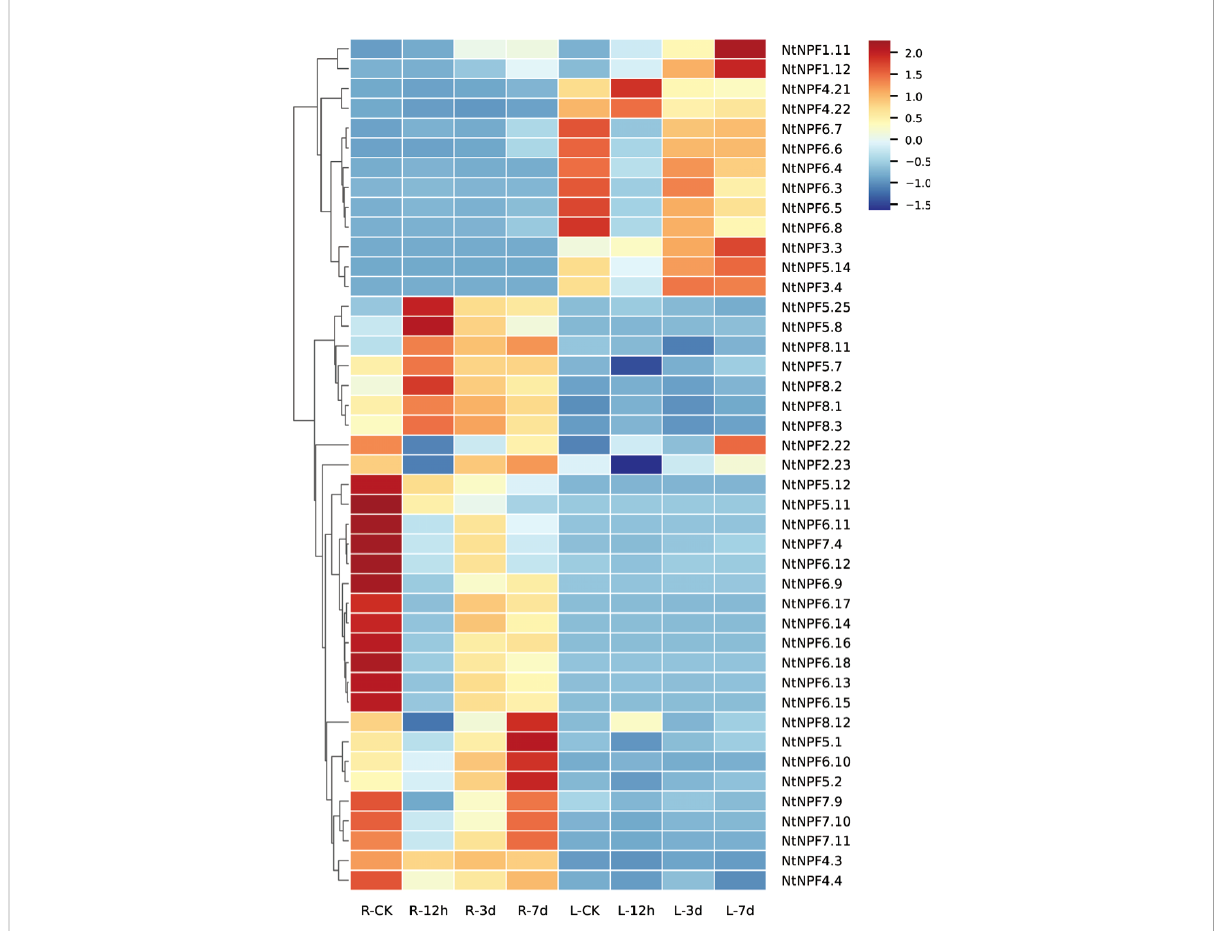
FIGURE 5 Expression pro fi les of NtNPF genes responsive to salt stress in roots and leaves of tobacco. R-CK, R-12h, R-3d and R-7d represent root samples, and L-CK, L-12h, L-3d and L-7d represent leaf samples. The expression values are shown as the z score of the RPKM values. The scale bar is shown on the right, and high expression levels are indicated by a red